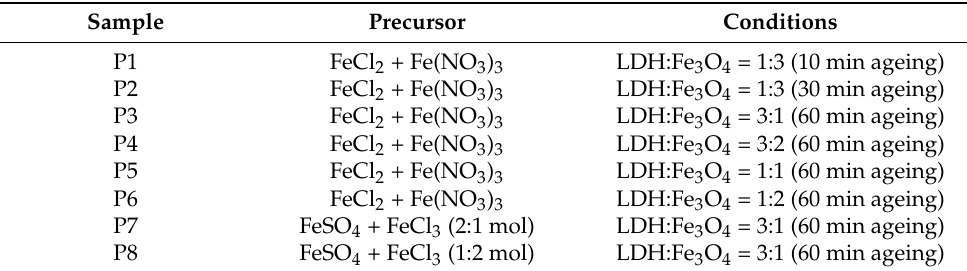
Table 1. The preparation details for the catalysts prepared using different LDH:MNP ratios and from different MNP precursors.